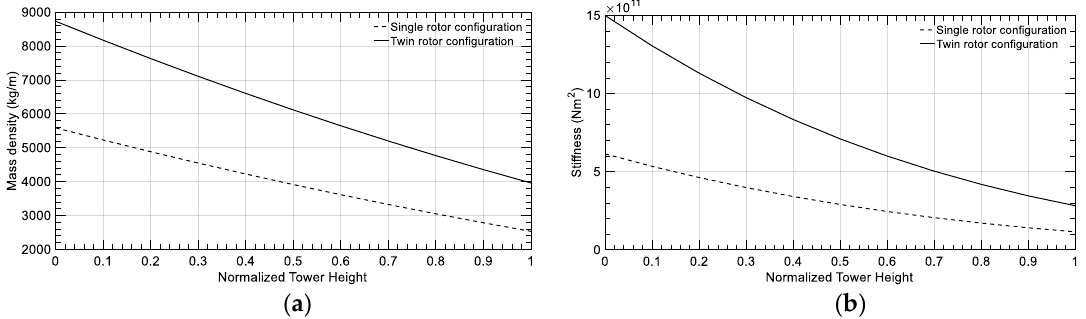
Table 3. Tower geometry.